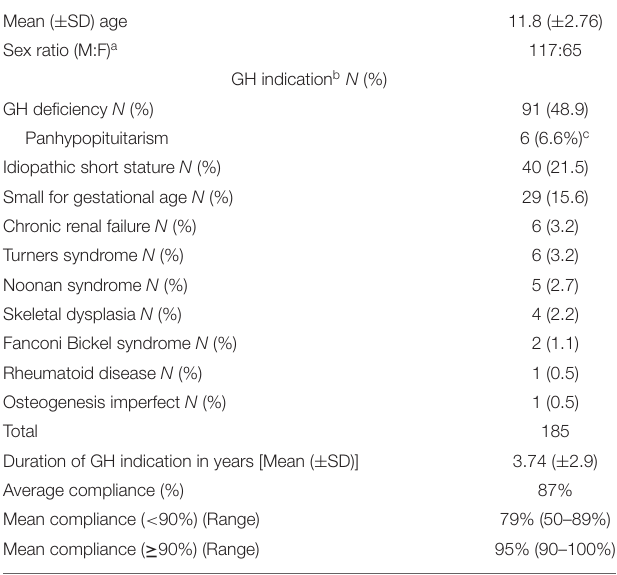
TABLE 1 | Baseline demographic profile ( N =